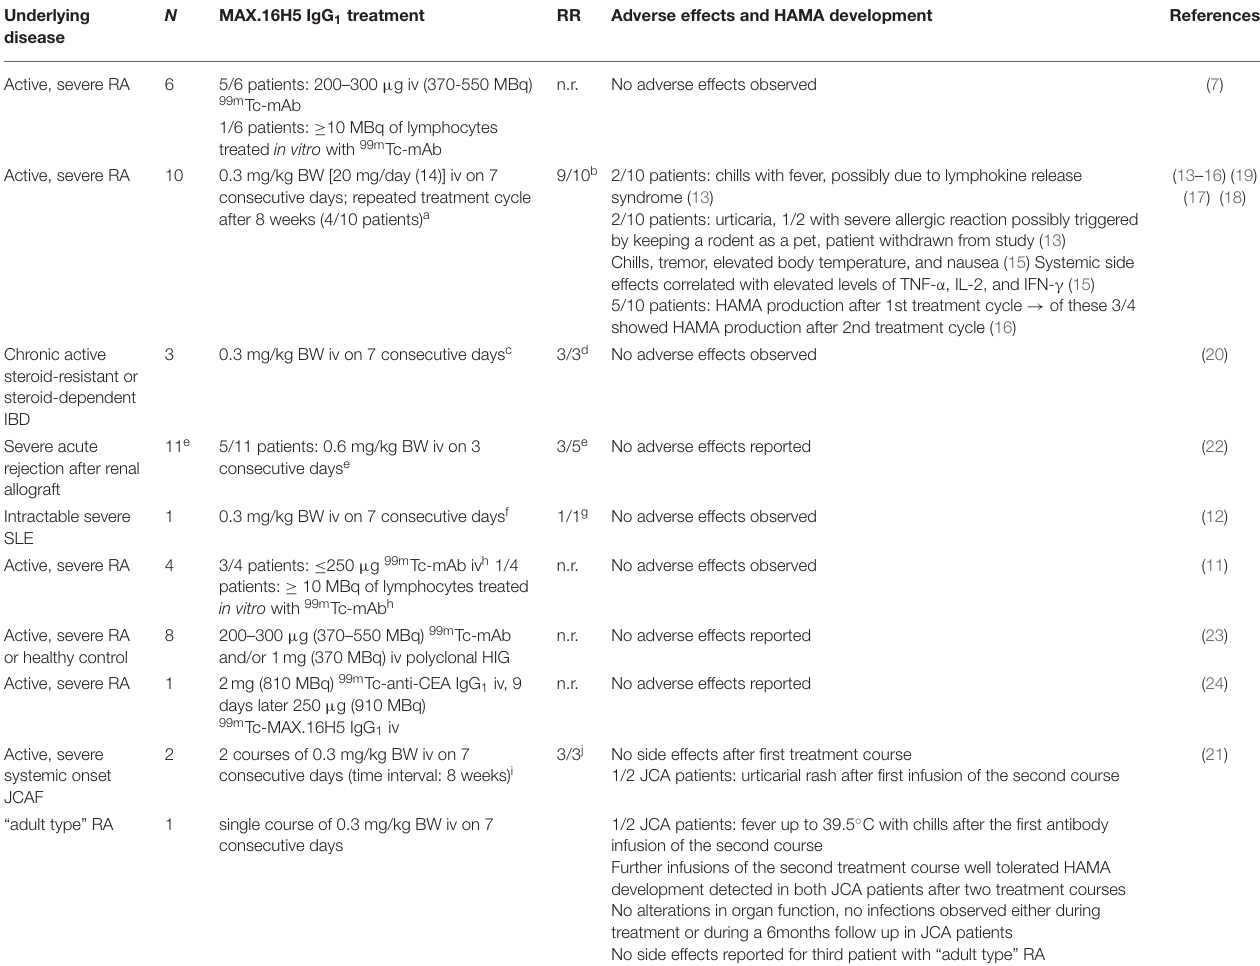
TABLE 1 | Results of human studies using MAX.16H5 IgG 1